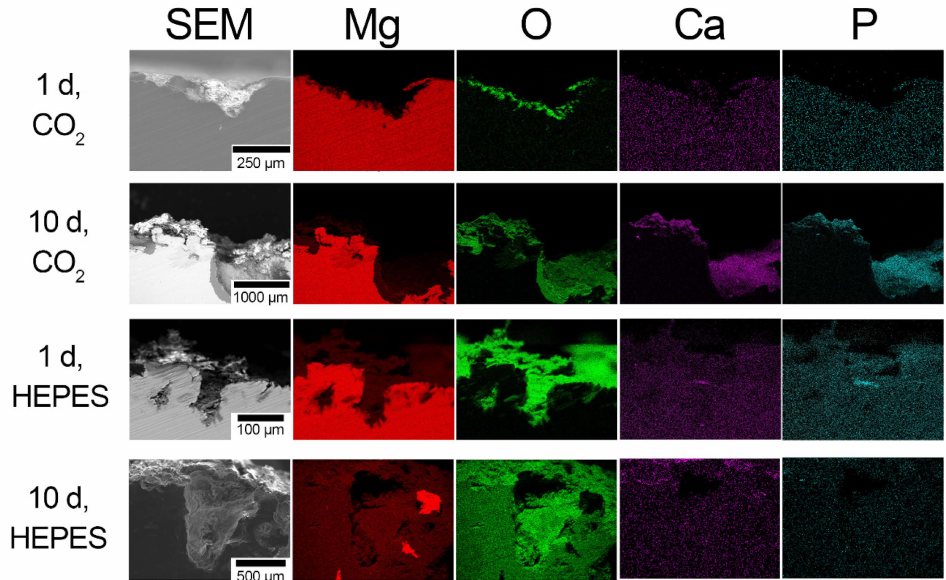
Figure 6. Scanning electron micrographs and corresponding elemental EDS maps taken from the cross-section (transverse plane) of R50 as a function of the buffer system and immersion time in